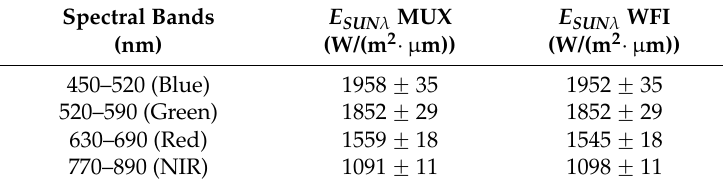
Table 2. Solar Exoatmospheric spectral irradiances ( E SUN λ ) for MUX and WFI spectral